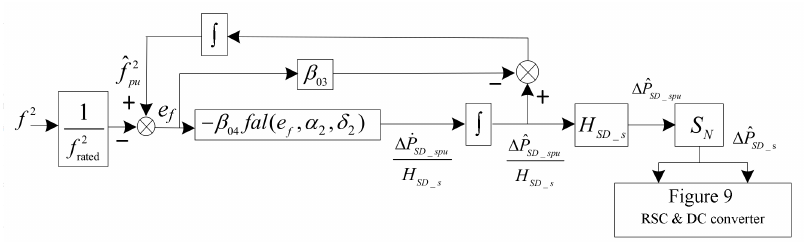
Figure 5. Operational principle of ESO-B.